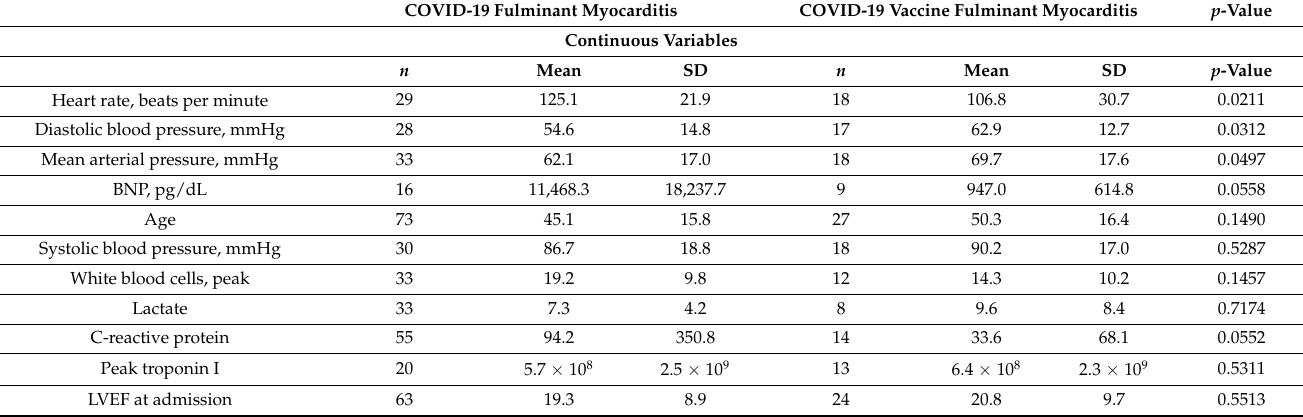
Table 3. Comparison of clinical features and outcomes of fulminant myocarditis and cardiogenic shock following COVID-19 and COVID